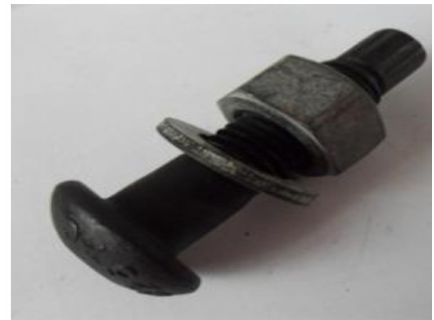
Figure 1. The high-strength bolt connection.